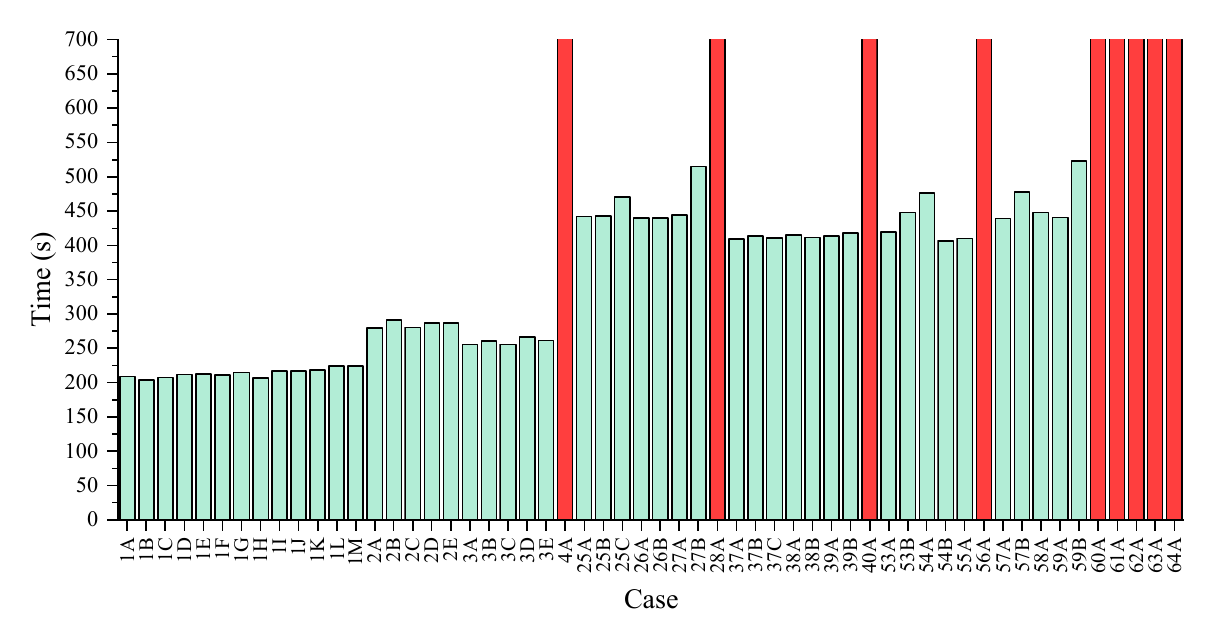
Figure 16. Evacuation action time of all cases calculated by the evacuation simulation. Figure 17 shows the real-time change of the number of occupants on each floor over time, taking Cases 1A, 2A, and 25A as examples. Table 6 shows the evacuation time for the occupants of each floor in all cases. It can be found that the occupants on the fourth floor completed the evacuation in only 45.8 s, the occupants on the third floor took about 184 s~191 s to complete the evacuation, and the occupants on the second floor completed the evacuation in 189~212 s. The differences in evacuation time in these cases are limited, which may be due to subtle differences in models and occupant distribution. However, there are significant differences in the evacuation time of the occupants located on 1F in different cases. The evacuation completion time of Case 1B is the shortest, only 204.2 s, while the evacuation completion time of Case 59B reached 522.8 s. In general, occupants on the first floor require a longer evacuation time than those on other floors and, as the total evacuation time of the theater is the maximum of the evacuation times on each floor, the evacuation time of the occupants on the first floor is critical to the total evacuation time.